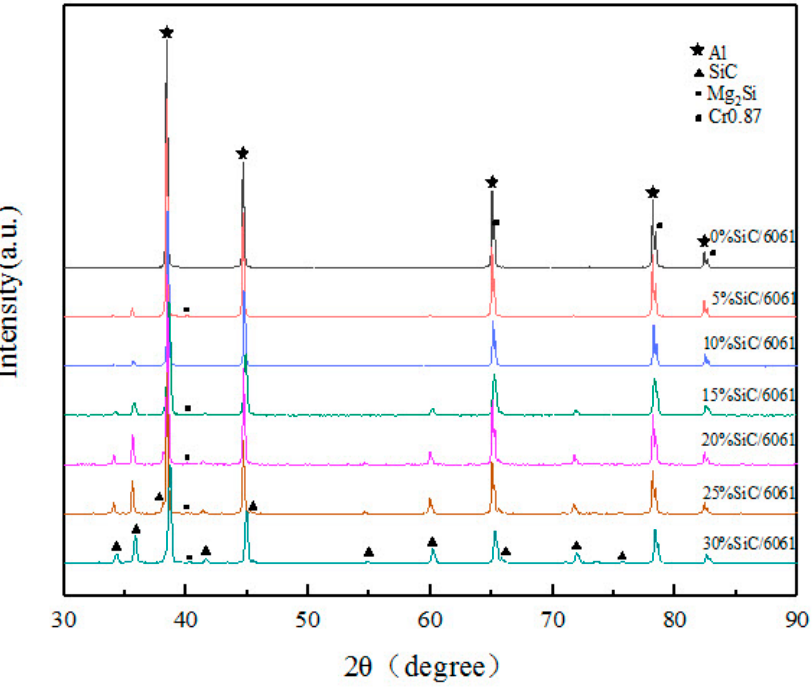
Figure 7. X-ray diffraction (XRD) pattern of SiC p /6061Al composites. Figure 7. X-ray di ff raction (XRD) pattern of SiC p / 6061Al